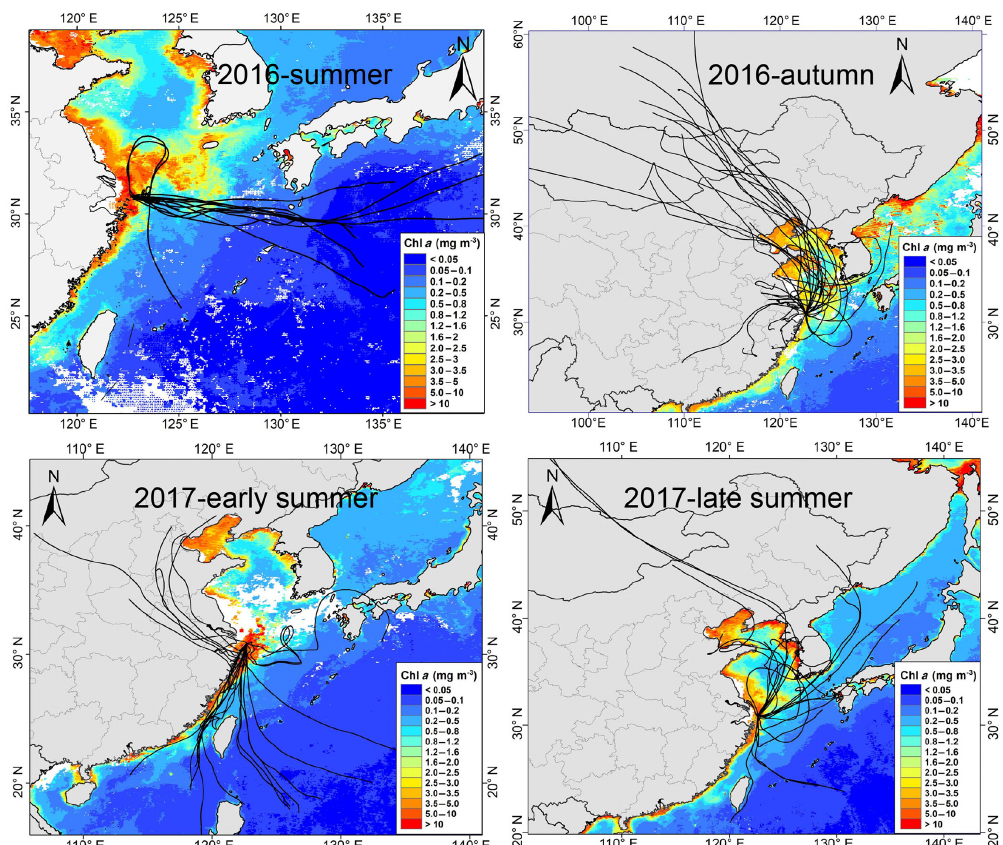
Figure 11. The 72h backward trajectories starting from Huaniao Island and the average Chl a concentration retrieved and combined from Aqua-MODIS and Terra-MODIS during the sampling period. Each sample during the summer of 2016 corresponds to one trajectory with a starting time in the middle of sampling period. Each sample set during the autumn of 2016 and the summer of 2017 corresponds to three trajectories and the starting times are taken at equal intervals in the sampling period.